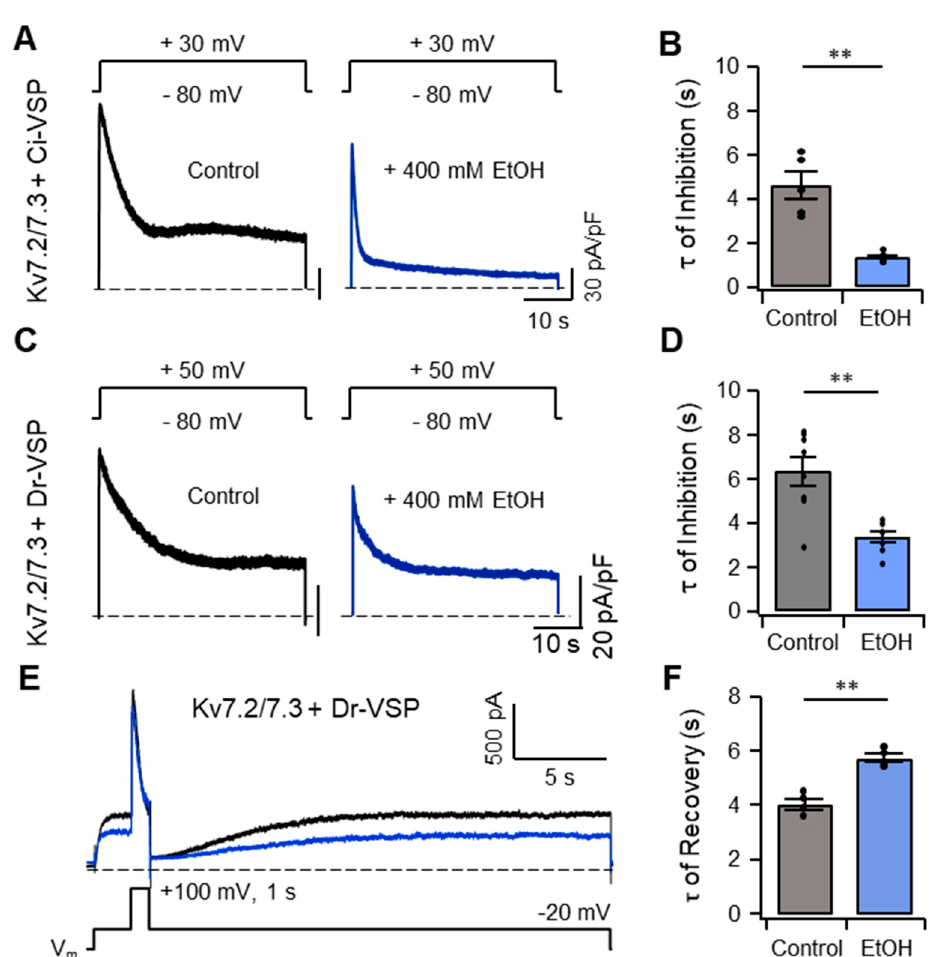
Figure 7. Inhibition of Kv7.2/7.3 currents by ethanol is facilitated by hydrolyzing plasma membrane PI(4,5)P 2 using a voltage-sensing phosphatase. ( A,C ) Representative current traces exhibited by tsA201 cells transfected with both Kv7.2 and Kv7.3, in combination with Ciona intestinalis VSP (Ci-VSP) ( A ) and Danio rerio VSP (Dr-VSP) ( C ) in response to increasing membrane potentials to +30 mV and +50 mV in the absence (black symbols) and presence of ethanol (blue symbols), respectively. The dashed line indicates zero current. ( B,D ) Time constants ( τ ) for inhibiting Kv7 current caused by activation of Ci-VSP ( B , n = 5 each) and Dr-VSP ( D , n = 8 each) in the absence (black bars) and presence of ethanol (blue bars). ( E ) Representative current traces exhibited by tsA201 cells transfected with Kv7.2, Kv7.3, and Dr-VSP in response to changes in membrane potential from − 80 to +100 mV, followed by − 20 mV in the absence (black symbols) and presence of ethanol (blue symbols). ( F ) Time constants ( τ ) for recovery of Kv7.2/7.3 current after activation of Dr-VSP in the absence (black bar, n = 5) and presence of ethanol (blue bar, n = 4). Data are mean ± SEM. Mann–Whitney u -test, ** p < 0.01.